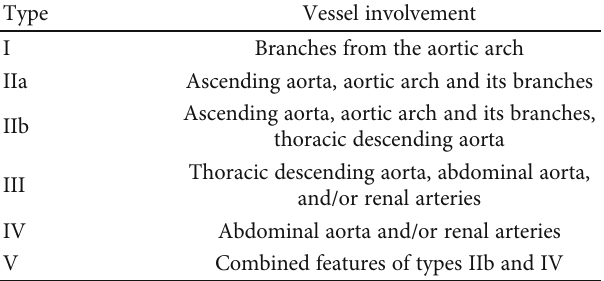
Table 1: Angiographic classi fi cation of Takayasu ’ s arteritis [4].